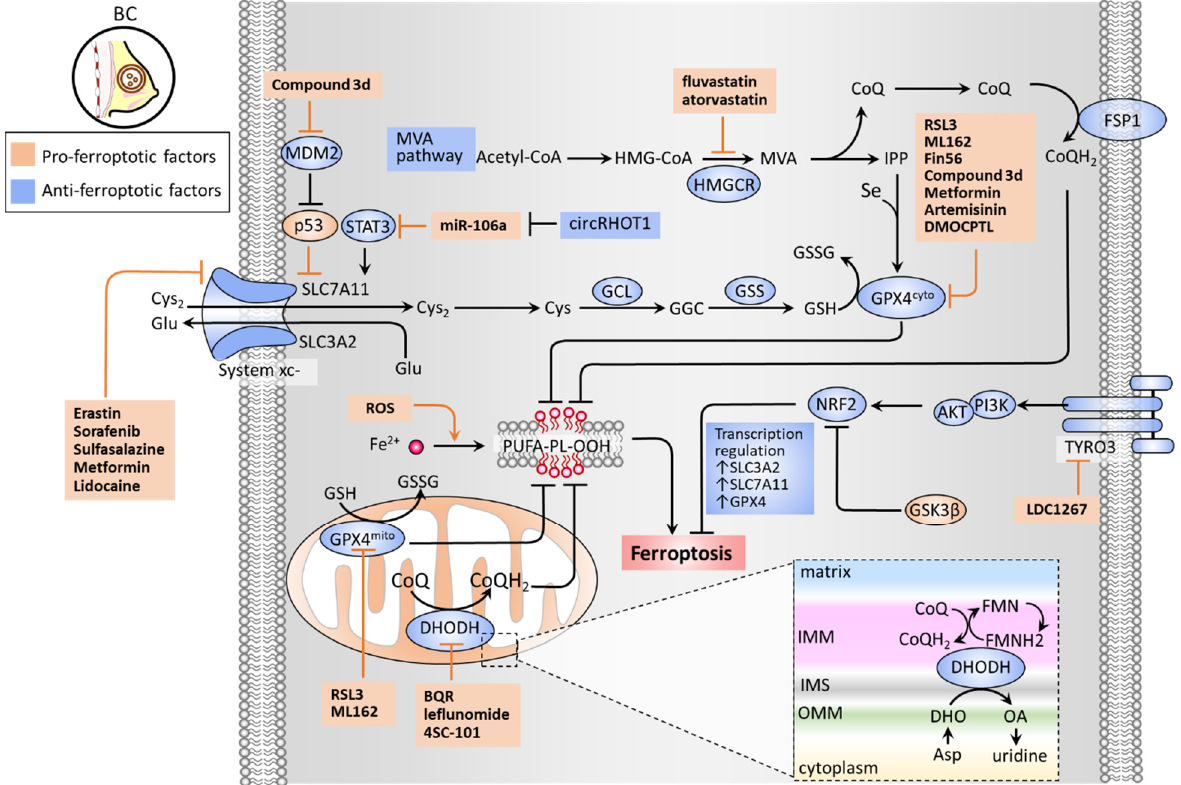
Figure 2. Antioxidant defense system that regulates ferroptosis. GSH-dependent pathways (GSH/GPX4 and MVA) and GSH-independent pathways (FSP1/CoQ10 and DHODH/CoQ10) constitute an antioxidant defense system. System xc − composed of SLC3A2 and SLC7A11 is a cystine/glutamate antiporter that imports Cys2 into cells with an equal amount of counter-transport of glutamate. The Cys 2 is oxidized to cysteine (Cys), which contributes to the synthesis of GSH in a reaction catalyzed by glutamate-cysteine ligase (GCL) and glutathione synthetase (GSS). Cytosolic and mitochondrial GPX4 (GPX4 cyto and GPX4 mito ) eliminates ROS by converting GSH to GSSG. The MVA pathway requires HMGCR as a critical rate-limiting enzyme to generate IPP and CoQ10. IPP is involved in the synthesis of GPX4 in the presence of Se, while CoQ10 plays an important role in suppressing lipid peroxidation. FSP1 repairs lipid peroxidation on the plasma membrane by converting CoQ10 to CoQH 2 . By contrast, DHODH generates CoQH2 by reducing CoQ10 through a uridine-synthesizing redox reaction that catalyzes DHO to OA to exert a protective effect on lipid peroxidation at the mitochondrial membrane. TYRO3 acts toward anti-ferroptosis by the PI3K/AKT/NRF2 axis to bolster the activity of GSH/GPX4. Abbreviations: BQR, brequinar sodium; circRHOT1, circular RNA RHOT1; CoQ10, coenzyme Q10; Cys, cysteine; Cys2, cystine; DHO, dihydroorotate; DHODH, dihydroorotate dehydrogenase; FSP1, ferroptosis suppressor protein 1; GCL, glutamate-cysteine ligase; GPX4, glutathione peroxidase 4; GSH, glutathione; GSK3B, glycogen synthase kinase 3 beta; GSS, glutathione synthetase; HMGCR, HMG-CoA reductase; IMM, inner membrane of mitochondria; IMS, intermembrane space; IPP, isopentenyl-pyrophosphate; MDM2, mouse double minute 2; MVA, mevalonate; NRF2, nuclear factor, erythroid 2-like 2; OA, orotate; ROS, reactive oxygen species; OMM, outer membrane of mitochondria; Se, selenium; SLC3A2, solute carrier family 3 member 2; SLC7A11, solute carrier family 7 member 11; STAT3, signal transducer and activator of transcription 3; TYRO3, tyrosine-protein kinase receptor 3.